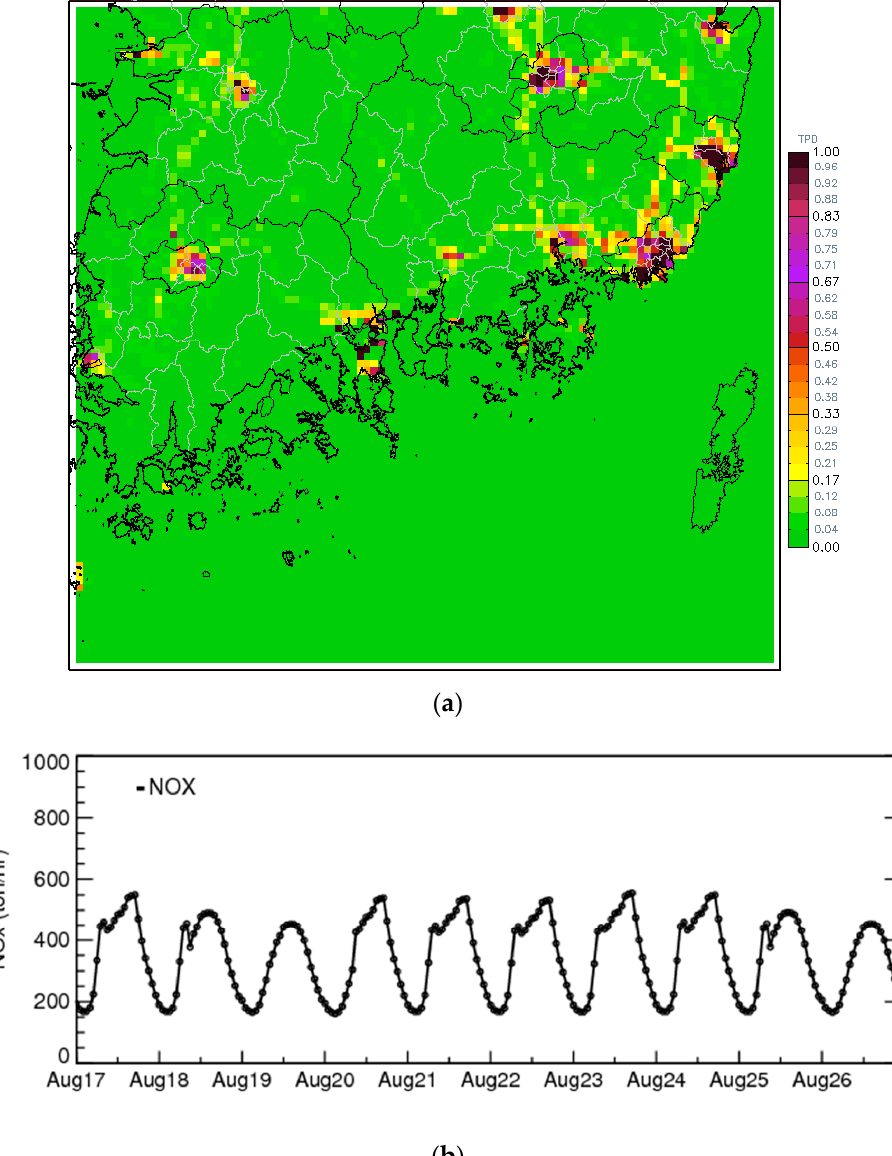
Figure 4. Spatial distribution of period average NO x emissions ( a ) and hourly domain-wide total NO x emissions ( b ) for 3-km domain.